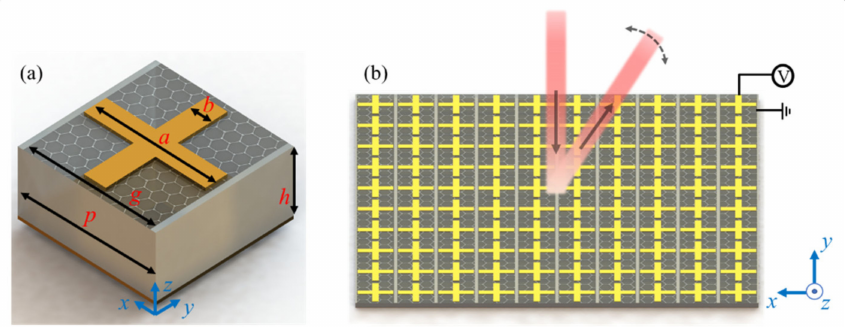
Figure 1. ( a ) Sketch of the unit cell for the proposed active graphene-metal hybrid metasurface. The structural parameters include a = 2.1, b = 0.4, g = 2.3, p = 2.5, and h = 0.23 µ m. ( b ) OPA configuration-based metasurface